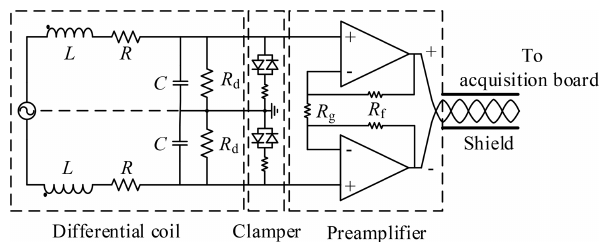
Figure 2. Schematic diagram of the differential Rx coil and pream- plifier. A diode clamper is used to protect the amplifiers from over- voltage during strong Tx